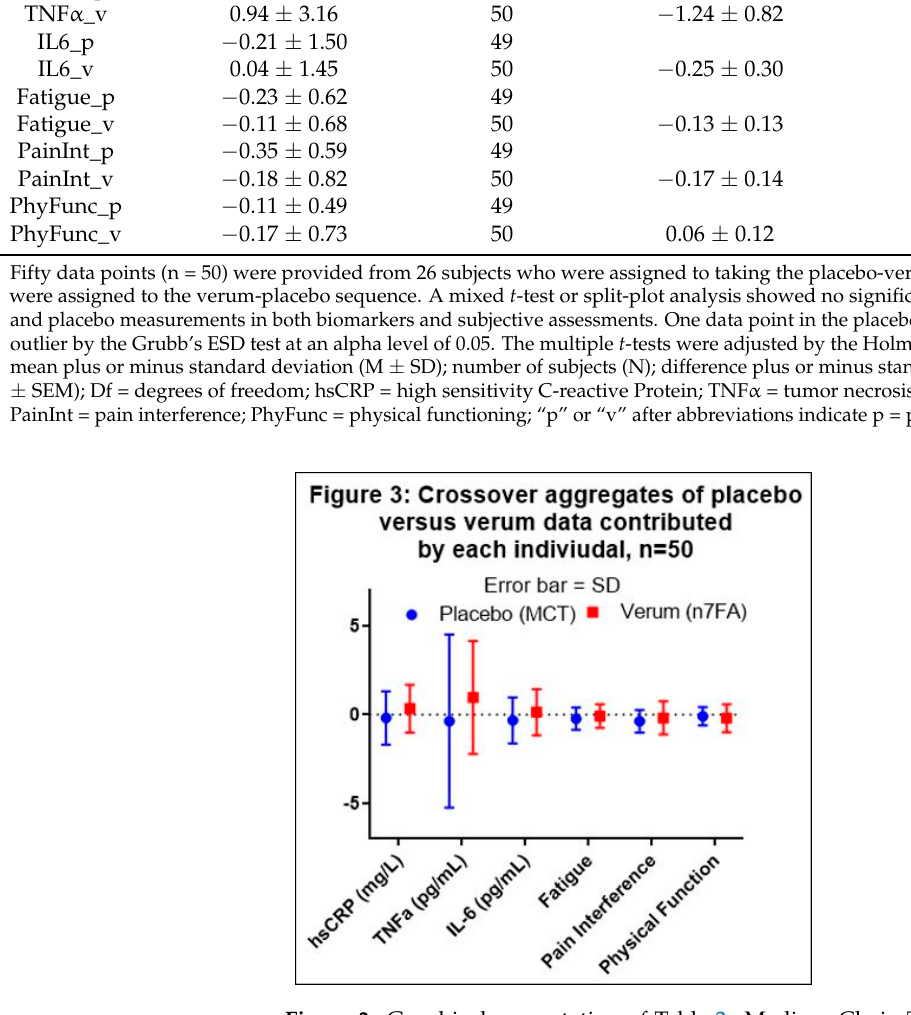
Table 3. Analysis of Fatty Acids in Placebo Capsules, Verum Capsules and Plasma. Placebo Capsule (mg/g)